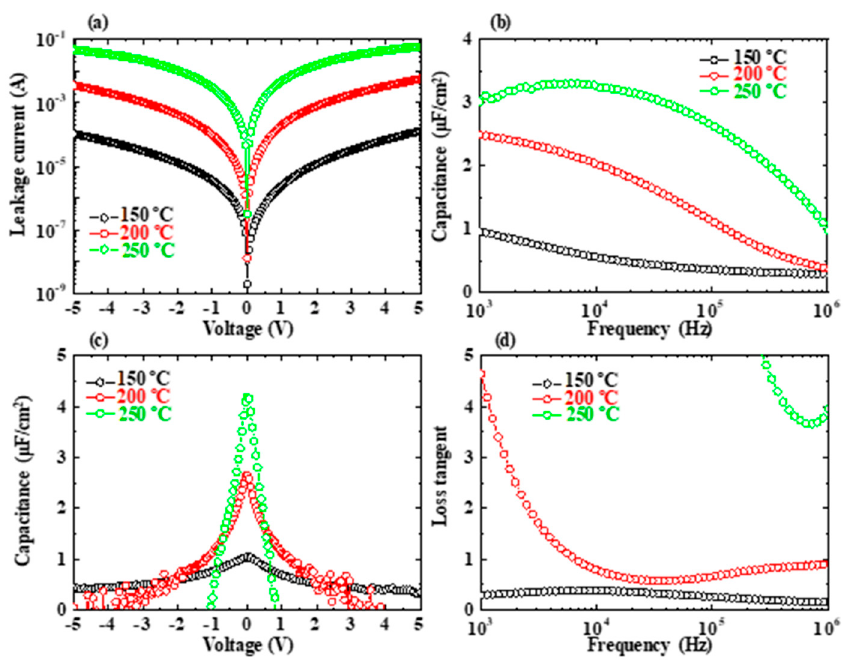
Figure 4. ( a – d ) Leakage current-voltage, capacitance-frequency, capacitance-voltage, and loss tangent-frequency characteristics of the Si/Ti/Pt/ATO NL/Ti/Au capacitors with the variation in ATO NL deposition temperature. The ATO NL and sublayer thicknesses are the same at around 50 nm and 0.5A/0.5T, respectively. Their deposition temperatures were 150 (black circle line), 200 (red circle line), and 250 °C (green circle line).